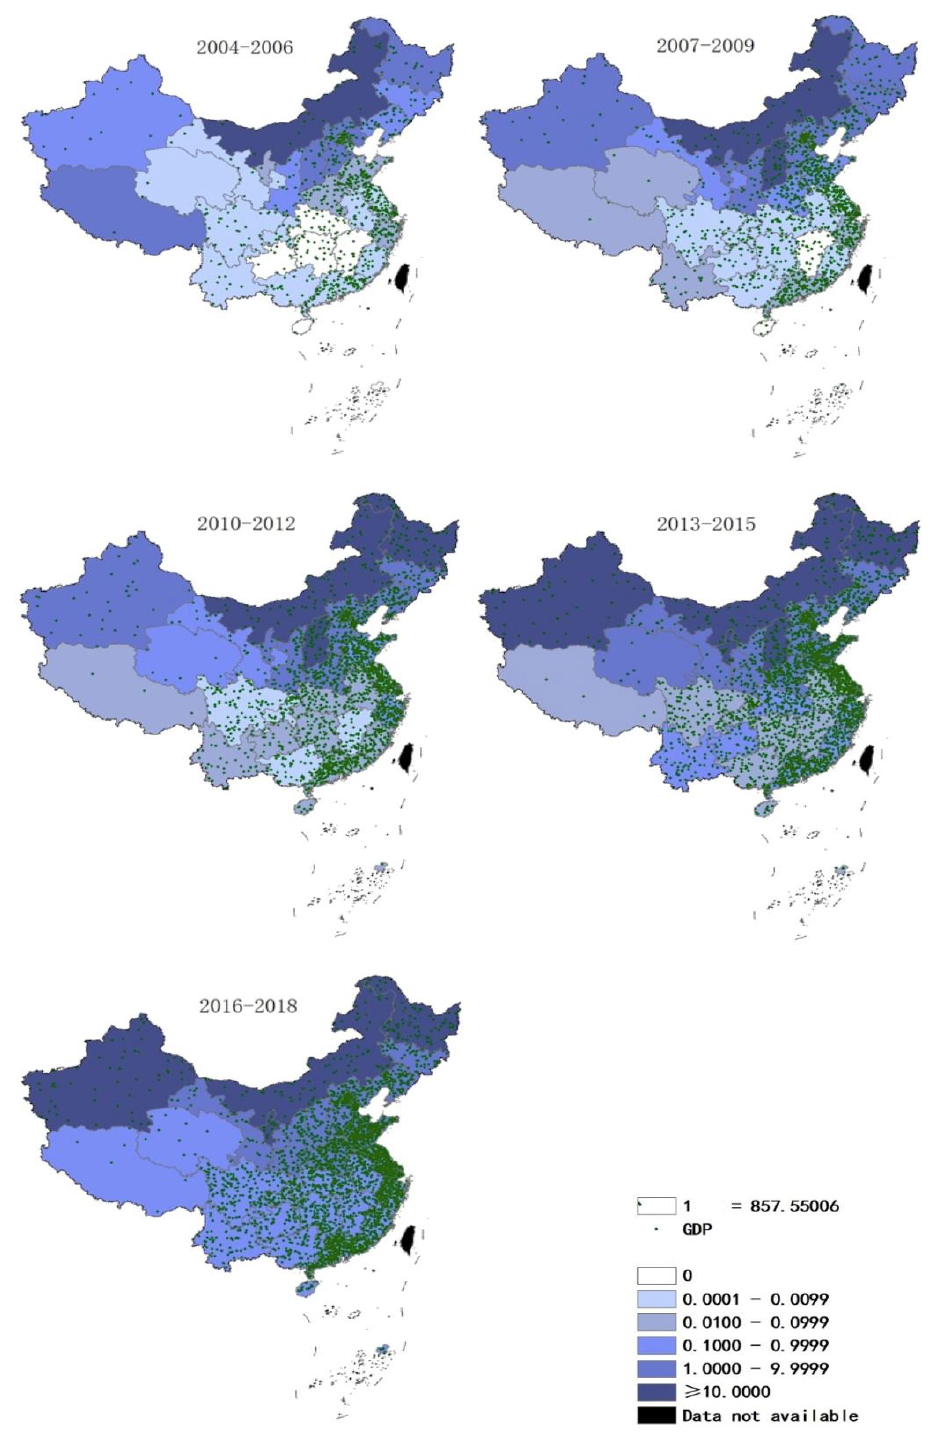
Figure 4. Annual incidence and gross domestic product (GDP) ( / 100 million yuan) distribution in mainland China, 2004–2018 (by 3 year period). Through Spearman’s correlation analysis, we found that the correlation between per capita GDP levels and the incidence of HB in 2016–2018 was negative (Table 1). In other time periods, although the p -value was not statistically significant, the correlation coe ffi cients were all negative. This was similar to the result of another recently published paper